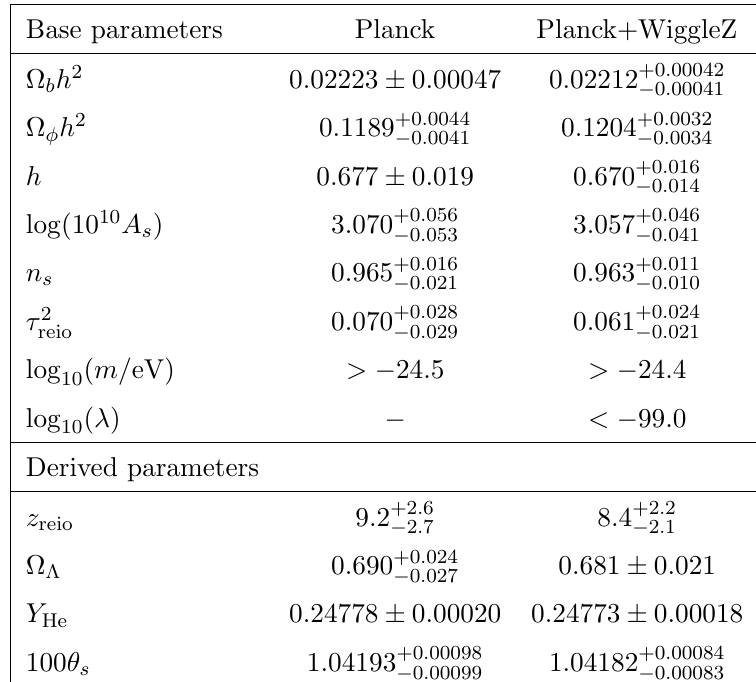
Table 2 . Best (cid:12)t results with 95% con(cid:12)dence level.